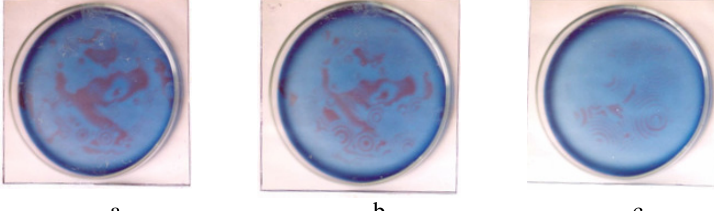
Figure 3 . Photographs of concentric wave pattern and nucleation. Concentrations and conditions are same as in Figure 1. (a) after 4 min (b) after 6 minutes (c) after 12 min.